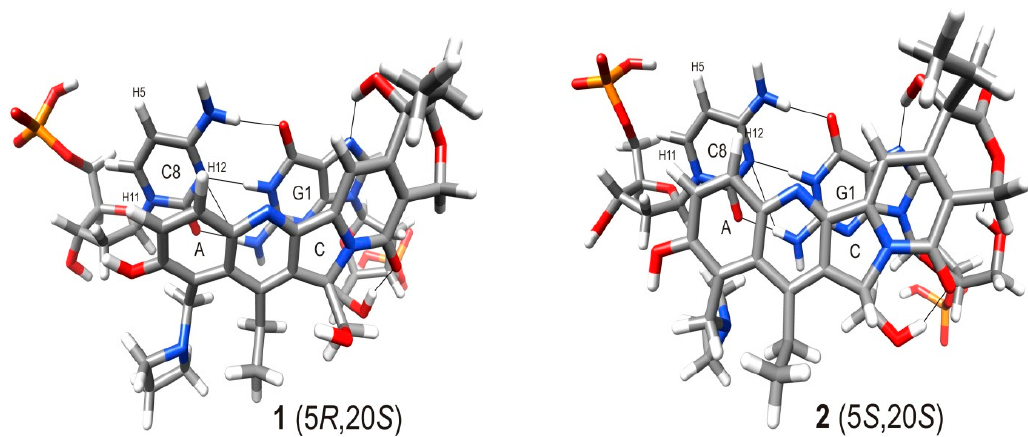
Table 6. Diastereomer 1 C5( R ), PM7 most populated cluster energies.